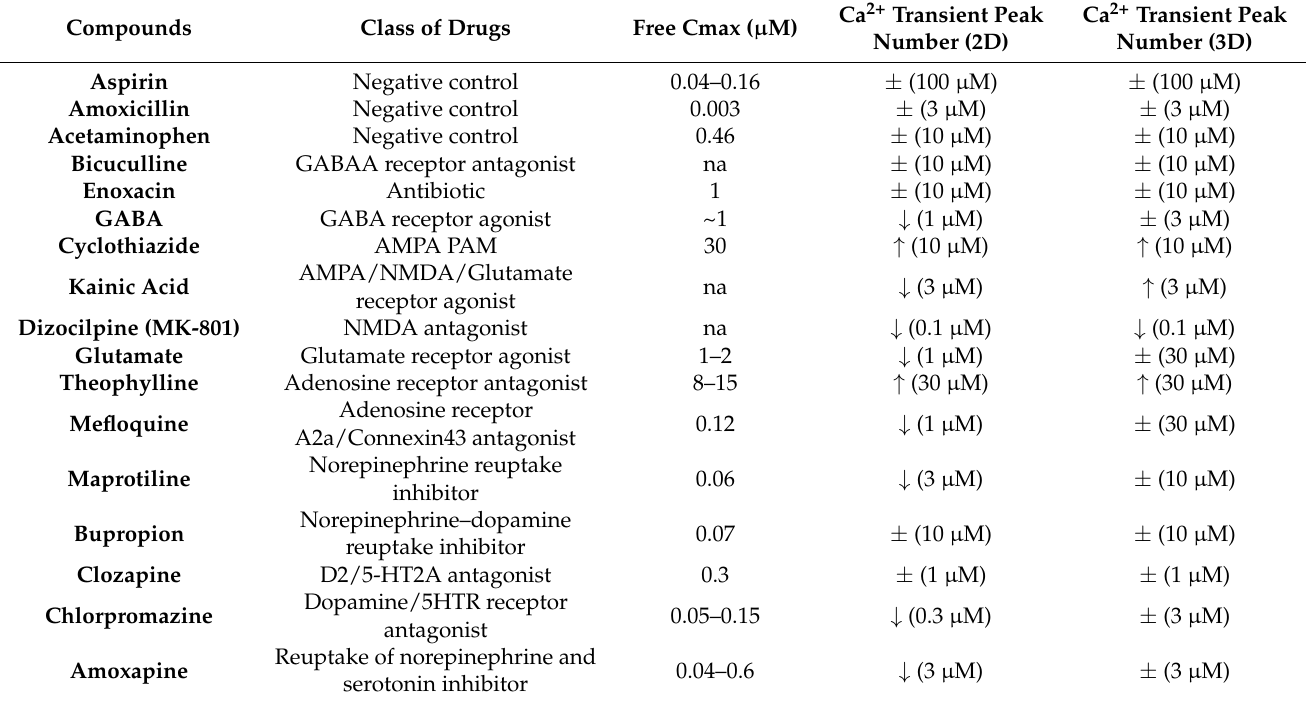
Table 2. Overview of the summarized effects of 25 reference drugs on Ca 2+ neuronal oscillations— Ca 2+ peak number in hiPSC-derived neurons co-cultured with human primary astrocytes in 2D and 3D, relative to its free